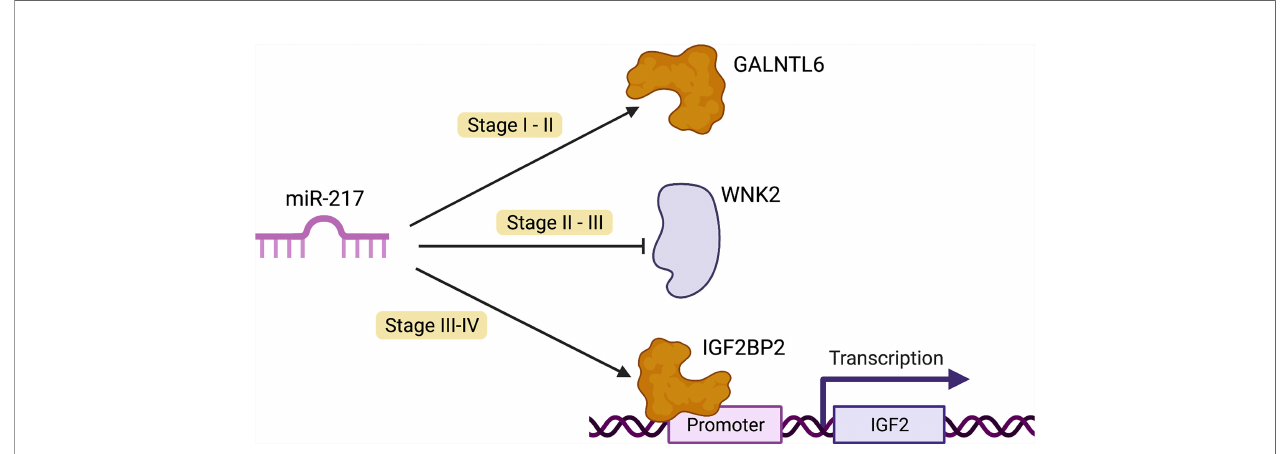
FIGURE 6 | Possible oncogenic role of miR-217. In cancer transition one (stage I – II), miR-217 allows GALNTL6 overexpression. This protein typically initiates post- translational modi fi cations in the Golgi apparatus. Additionally, in cell culture models, these enzymes affect the ER via aberrant Src signaling. In stages II – III (transition two), miR-217 represses WNK2 expression, a tumor suppressor which inhibits cell proliferation by negatively modulating the activation of the MEK1 pathway. In the last transition (stages III – IV), miR-217 enables IGF2BP2 overexpression. This gene promotes tumor progression in several types of cancer, such as glioblastoma multiforme and gallbladder cancer. IGF2BP2 also promotes tumor cell proliferation through the PI3K-Akt pathway